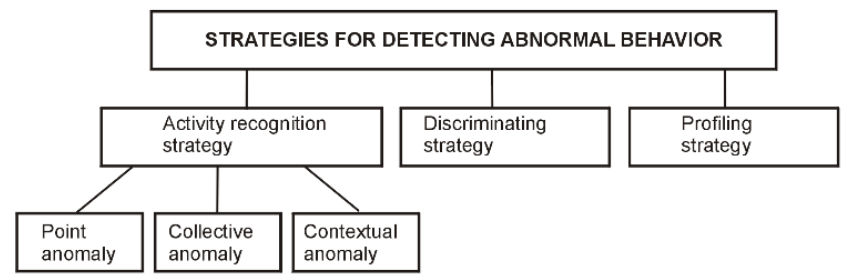
Figure 1. An overview of the existing strategies for detecting abnormal behavior (based on Refs. [27,28]). In the Activity Recognition Strategy, depending on the granularity of the